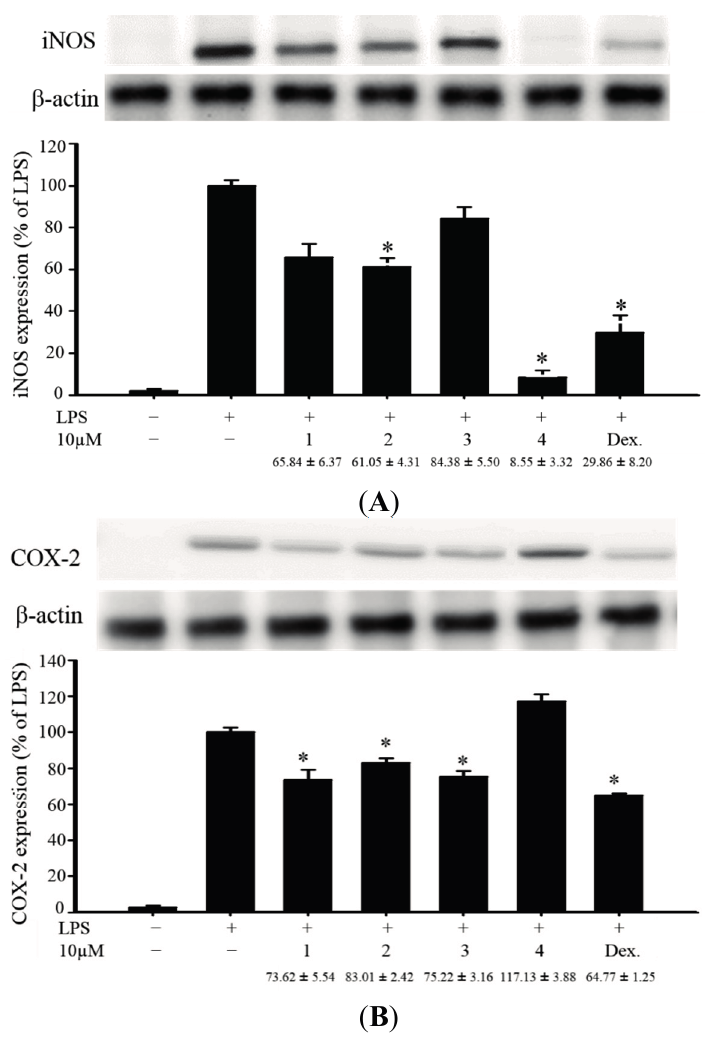
Figure 4. Effects of compounds 1 – 4 on pro-inflammatory iNOS and COX-2 protein expression in LPS-stimulated murine macrophage cell line RAW264.7. ( A ) Relative density of iNOS immunoblot; ( B ) relative density of COX-2 immunoblot. The relative intensity of the LPS-stimulated group was taken to be 100%. Band intensities were quantified by densitometry and are indicated as the percent change relative to that of the LPS-stimulated group. Compound 4 and dexamethasone (Dex.) significantly inhibited LPS-induced iNOS protein expression in macrophage. The experiment was repeated three times. (* p < 0.05, significantly different from the LPS-stimulated